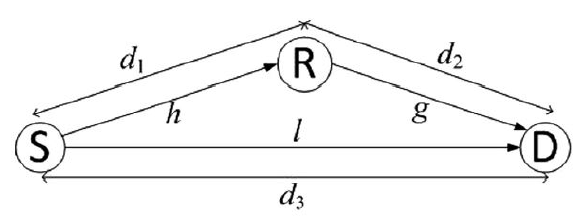
Figure 2. SWIPT-based relay architecture.